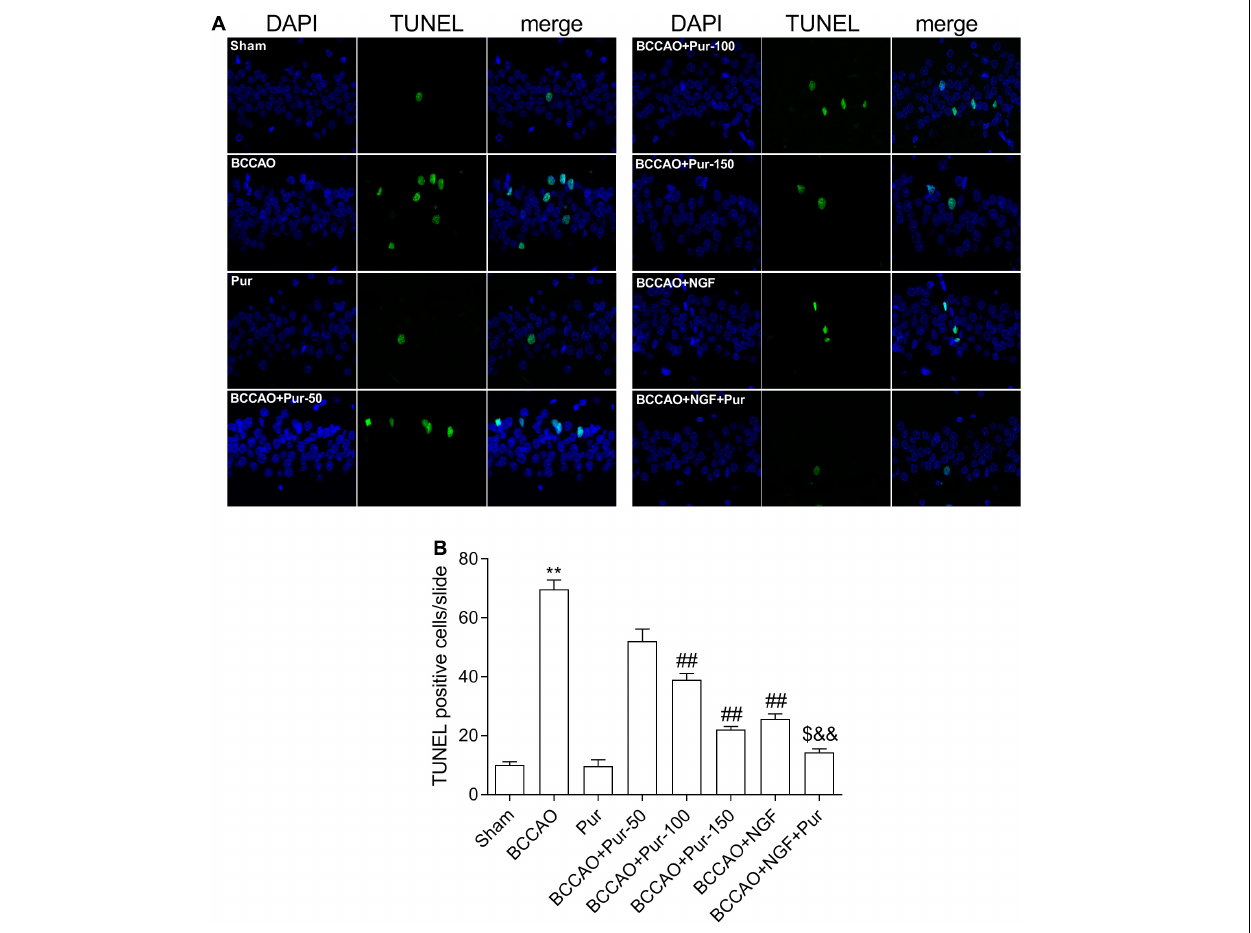
FIGURE 4 | Puerarin’s effects on apoptosis in dorsal CA1 region of hippocampal neurons in BCCAO rats (TUNEL staining). (A) Tunel staining to identify positive apoptotic cells (Red arrows), representative micrographs are shown at × 40. (B) The statistics of TUNEL positive cells. Values were mean ± SEM ( n = 6). ** P < 0.01 vs. Sham; ## P < 0.01 vs. BCCAO; $ P < 0.05 vs. BCCAO + Pur (150 mg/kg/day); && P < 0.01 vs. BCCAO + NGF (20